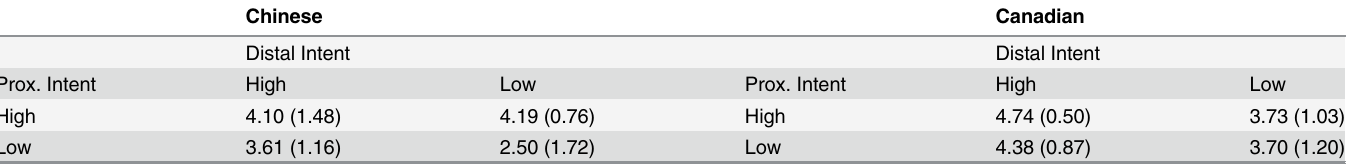
Table 2. Moral sanction of the actor. (Standard deviations in parentheses.)